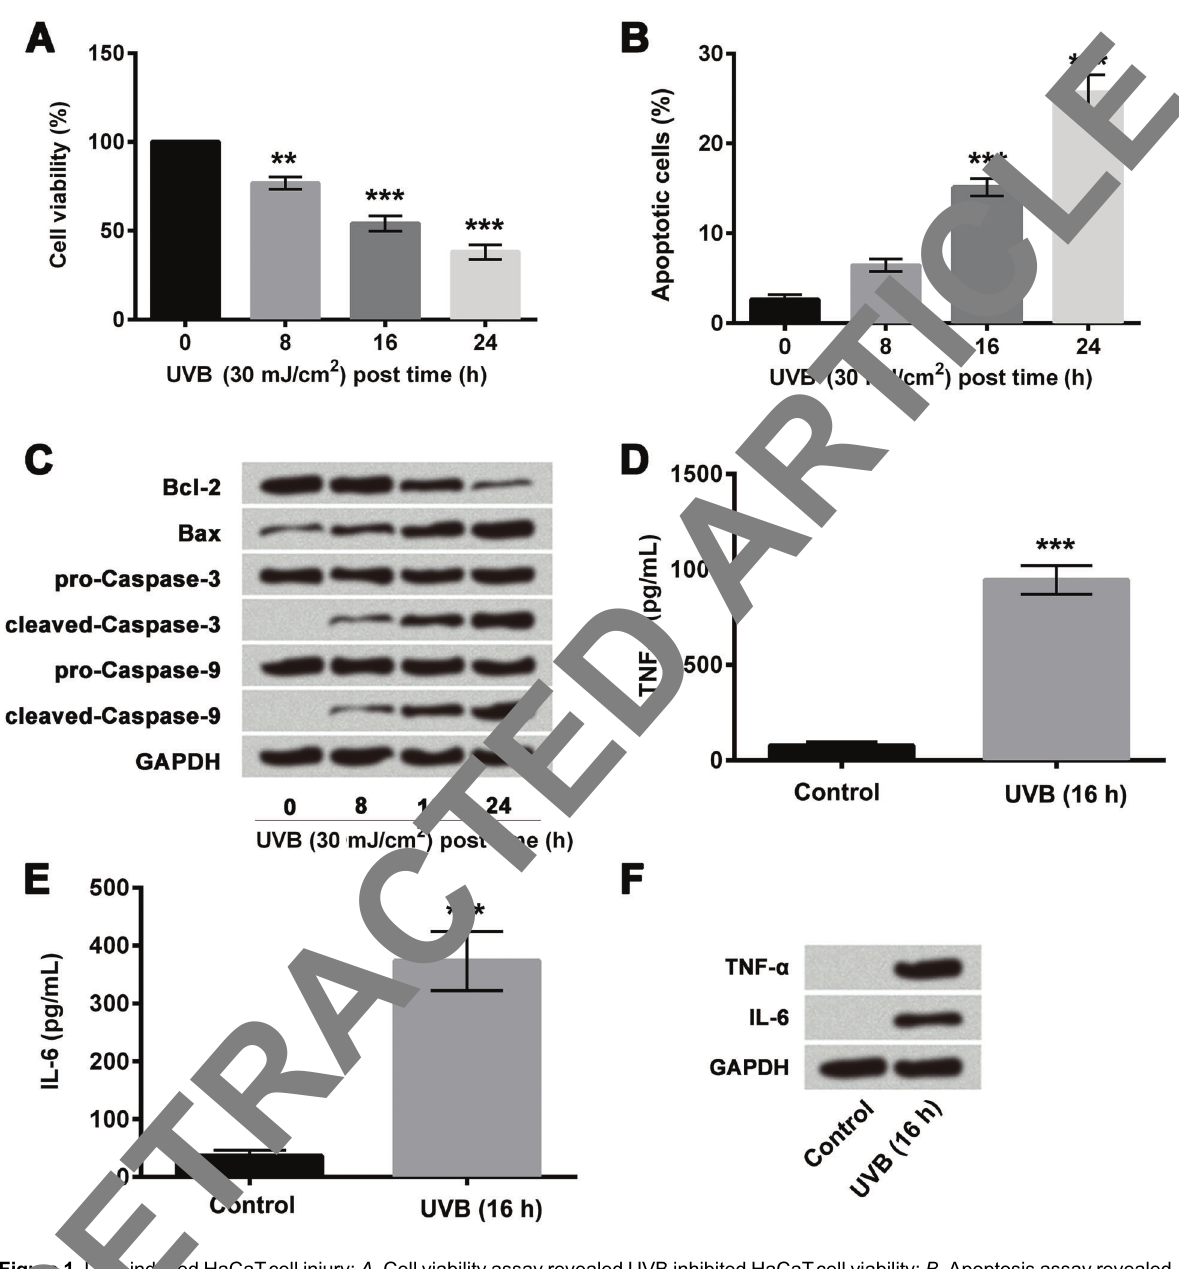
Figure 1. UVB induced HaCaTcell injury; A , Cell viability assay revealed UVB inhibited HaCaTcell viability; B , Apoptosis assay revealed UVB promoted HaCaT cell apoptosis; C , Western blotting analysis revealed increased expression of Bax, decreased expression of Bcl-2, and activation of caspase-3 and caspase-9; D , ELISA results demonstrated that UVB promoted the expression of TNF- a ; E , ELISA results demonstrated that UVB promoted the expression of IL-6; F , Western blotting analysis revealed overexpression of TNF- a and IL-6 in UVB-induced cells. Data are reported as means ± SD. **P o 0.01, ***P o 0.001 compared to control (ANOVA). UVB: ultraviolet B; ELISA: enzyme-linked immunosorbent assay; TNF- a : tumor necrosis factor- a ; IL-6: for 35 cycles (denaturation at 94°C for 45 s, annealing at The speci fi c PKR primers were: forward, 5 0 -CAGAAT 55°C for 45 s, extension at 72°C for 90 s). The speci fi c TGACGGAAAGACTTAC GTT-3 0 ; reverse, 5 0 -CATGA HOTAIR primers were: forward, 5 0 -CAGTGGGGAACTCT TCAAGTTTTGCCAATGC-3 0 . HOTAIR levels were nor- GACTCG-3 0 ; reverse, 5 0 -GTGCCTGGTGCTCTCTTACC-3 0 . malized to GAPDH: forward, 5 0 -GTC AACGGATTTG